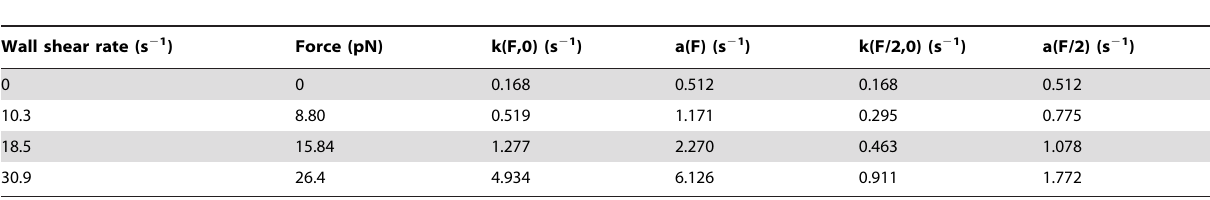
Wall shear rate (s 2 1 )